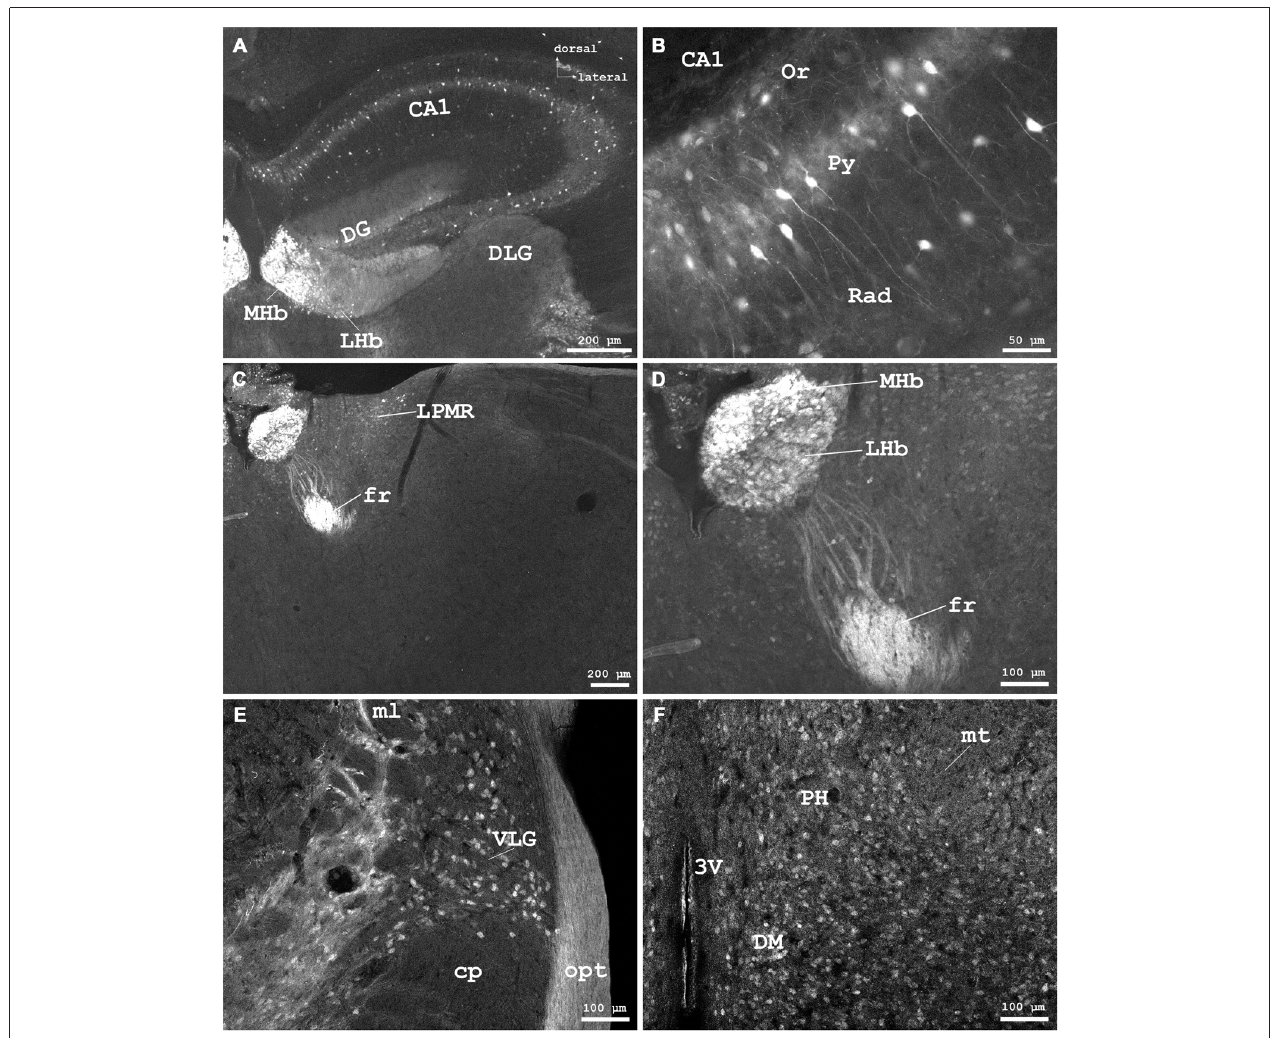
FIGURE 4 | Cygb-immunofluorescence in a frontal section of the mouse brain. (A) Habenular nuclei and anterior hippocampal formation at the level of approximately interaural +2.1 mm, corresponding to Figure 45 of the mouse brain atlas. Strong staining of neurons in the medial habenular nuclei (MHb), while those in the lateral nuclei (LHb) were less stained. (B) Higher magnification from the medial CA1 region of the hippocampus: strong immunostaining of neurons in the pyramidal cell layer (Py). A few neurons from the oriens layer (Or) and stratum radiatum (Rad) were also stained. (C) Habenular nuclei and fasciculus retroflexus (fr) at the level of approximately interaural +1.7 mm, corresponding to Figure 48 of the mouse brain atlas, (D) Higher magnification demonstrating fibers entering the fasciculus retroflexus. (E) ventral aspect of the lateral geniculate nucleus (VLG) between the optic tract (opt) and the medial lemniscus (ml). (F) Scattered neurons in the posterior hypothalamic area (PH) and the dorsomedial hypothalamic nucleus (DM). Abbreviations: 3V, third ventricle; CA1, Cornu ammonis 1; cp, cerebral peduncle; DG, dentate gyrus; DLG, dorsal lateral geniculate nucleus; LPMR, lateral posterior thalamic nucleus, mediorostral part; mt, mamillothalamic